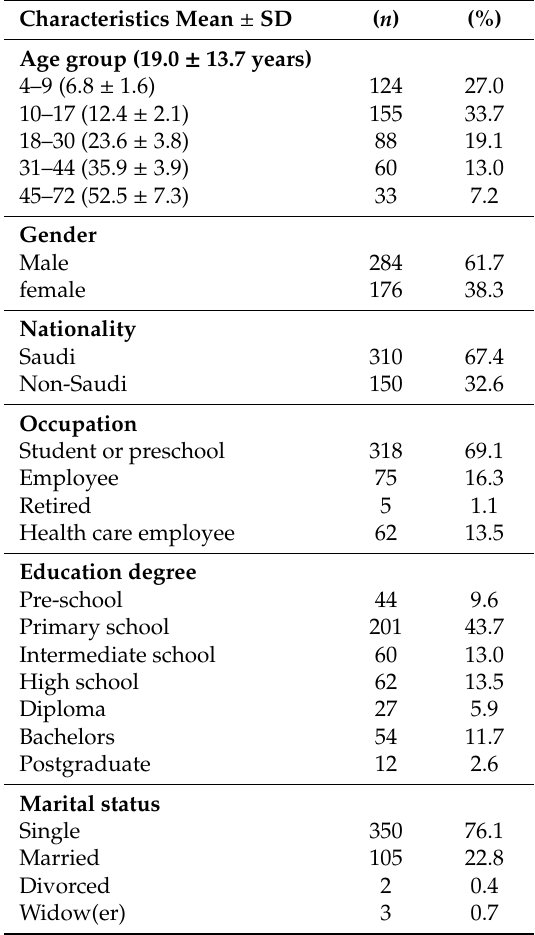
Table 1. Socio-demographic characteristics of the